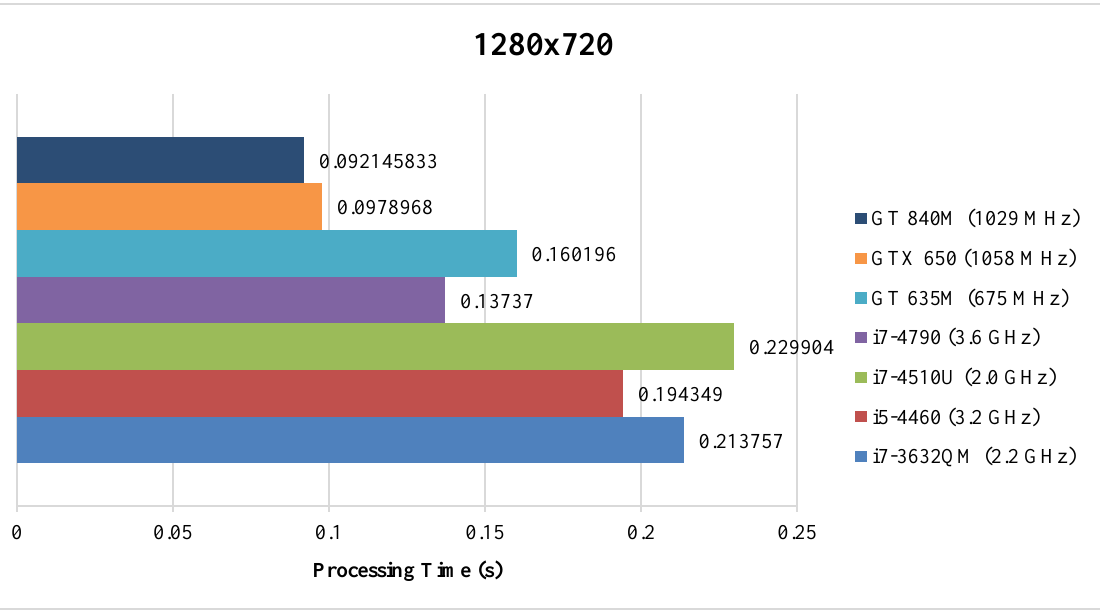
Figure 12. Compare the best runtime of different threads for different CPU and GPU to generate an image in 720p